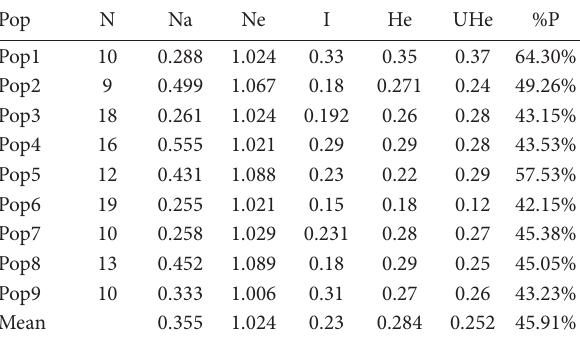
Table 4. Genetic diversity parameters in the studied populations Ae. tauschii (N = number of samples, Na = Number of different alleles, Ne = number of effective alleles, I= Shannon’s information index, He = gene diversity, UHe = unbiased gene diversity, P%= percent- age of polymorphism,